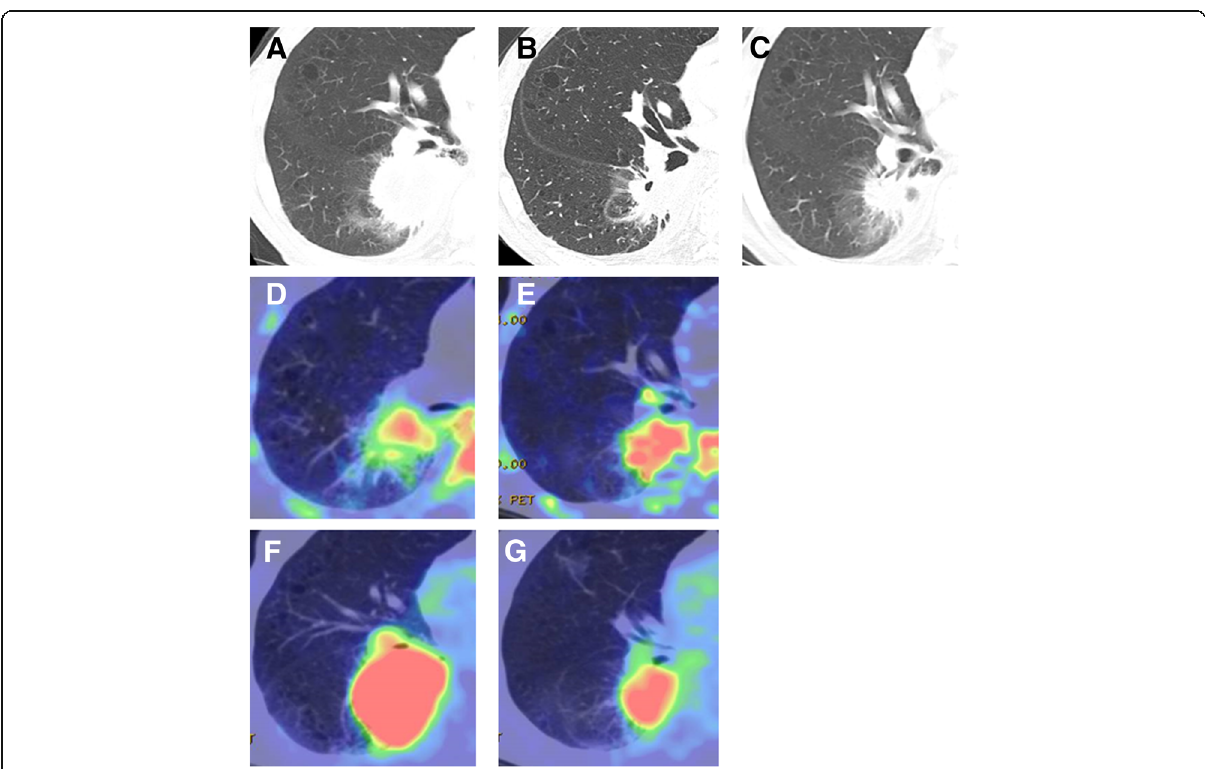
Fig. 1 a Chest CT image at baseline. b Chest CT image after 2 cycles of platinum-based doublet chemotherapy (PT-DC). c Chest CT image after 5 cycles of PT-DC. d 4DST PET/CT image at baseline. e 4DST PET/CT image after 2 cycles of PT-DC. f FDG PET/CT image at baseline. g FDG PET/CT image after 2 cycles of PT-DC. Chest CT image at baseline shows lung lesion with a diameter of 55 mm in the right lower lobe ( a ), with intense uptake of both FDG ( f ) (SUV max 15.8, MTV 81.0, TLG 672.5) and 4DST ( d ) (SUV max 4.7, MTV 13.6, TLP 42.1). After 2 cycles of PT-DC, the diameter of lung cancer has decreased to 22 mm ( b ), categorized as partial response based on RECIST. However, 4DST uptake and uptake area were increased after 2 cycles of PT-DC ( e ) (SUV max 4.9, MTV 18.2, TLP 56.4) compared to baseline 4DST PET/CT ( d ). FDG uptake and uptake area were decreased after 2 cycles of PT-DC ( g ) (SUV max 7.0, MTV 25.0, TLG 86.4), categorized as partial metabolic response based on EORTC and PERCIST. After 5 cycles of PDC, the lung lesion showed regrowth with a diameter of 30 mm ( c ), indicating recurrence. Recurrence could be predicted earlier with 4DST PET/CT than with chest CT or